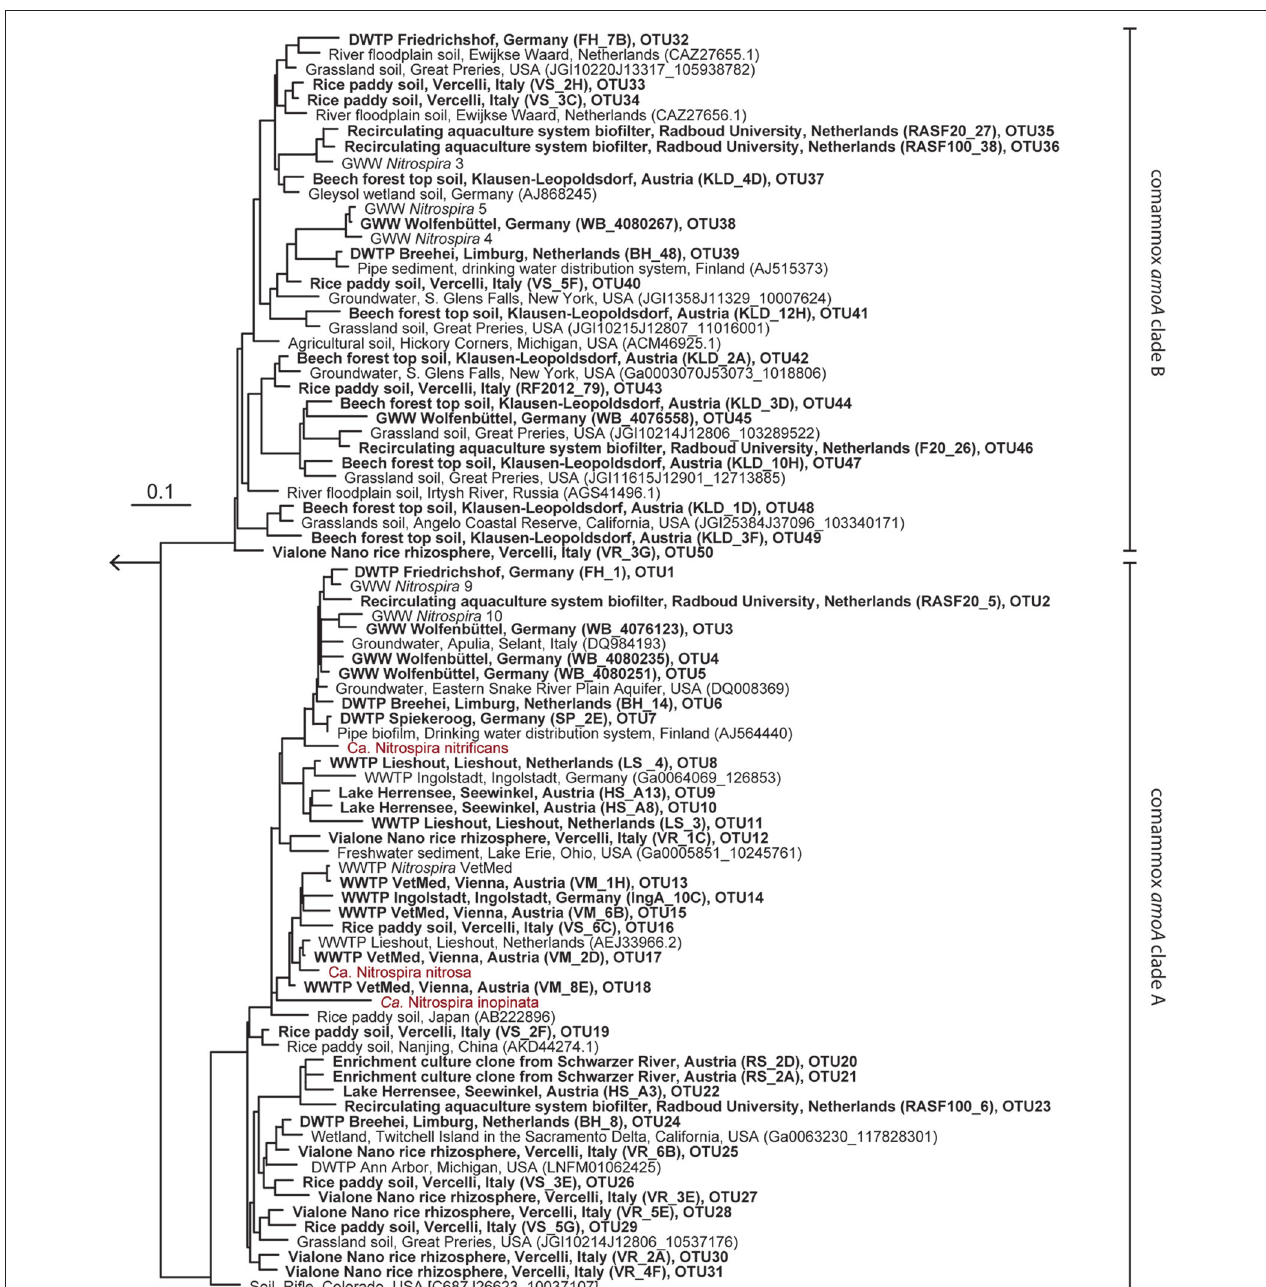
FIGURE 1 | Maximum likelihood tree showing the phylogenetic affiliation of comammox amoA genes obtained in this study (printed in boldface) to reference amoA sequences from comammox clades A and B. One representative sequence from each OTU is shown. Identifiers of clones (in parentheses) and of OTUs are indicated. Previously described comammox Nitrospira strains are shown in red. The outgroup consisted of selected betaproteobacterial amoA and proteobacterial pmoA genes. The scale bar indicates the estimated change rate per